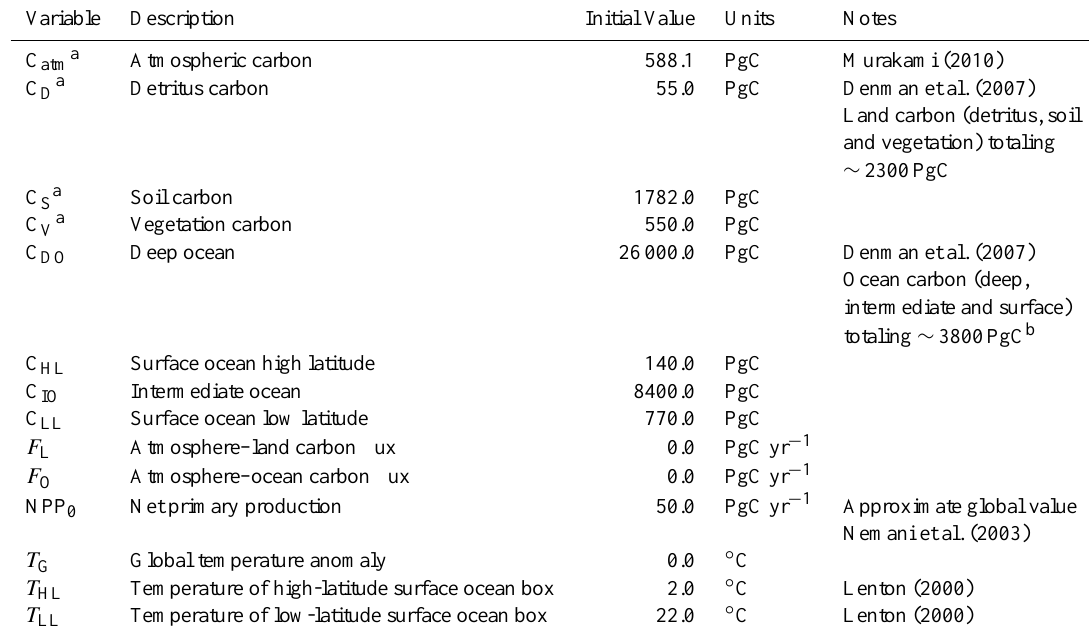
Table 1. Initial model conditions prior to the spinup phase. Carbon values change slightly after spinning up to a steady state.